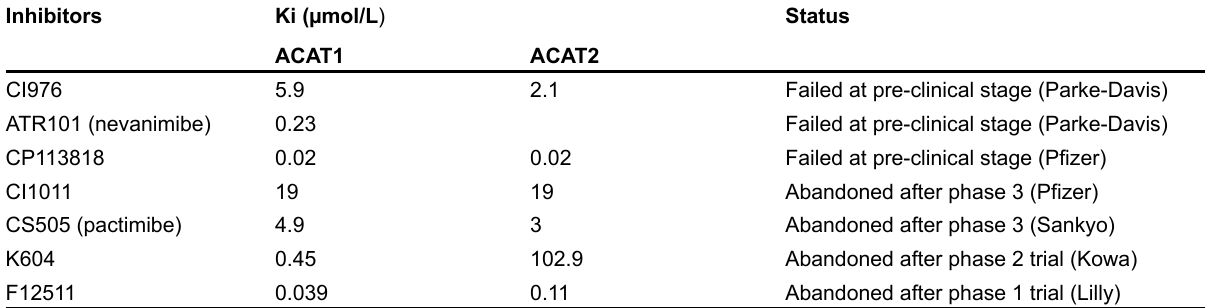
Table 1. ACAT inhibitors for anti-atherosclerosis purpose